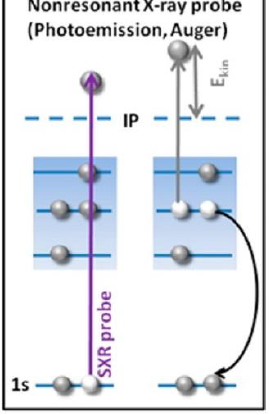
Figure 12. The Auger Effect, where we begin with a high-speed electron that knocks off an electron in the inner shell of an atom [157]. This leaves a vacant state (a 1s core hole), that is either filled by an upper electron that drops down to the inner shell, emitting a photon in the process (for heavy atoms, this energy is in the X-ray region, and thus results in X-ray fluorescence) or the excited ion relaxes by filling the core hole with an electron from a higher energy level, the resultant energy of this transition is taken up by an outer electron ejecting it from the atom, the Auger electron. The same is observed in the schematic where in non-resonant Auger spectroscopy, these vacancies are produced due to bombardment of a given sample with high energy electrons, in this case, a non-resonant X-ray pulse. Reprinted and adapted with permission from Ref [157] Copyright American Chemical Society (2016).